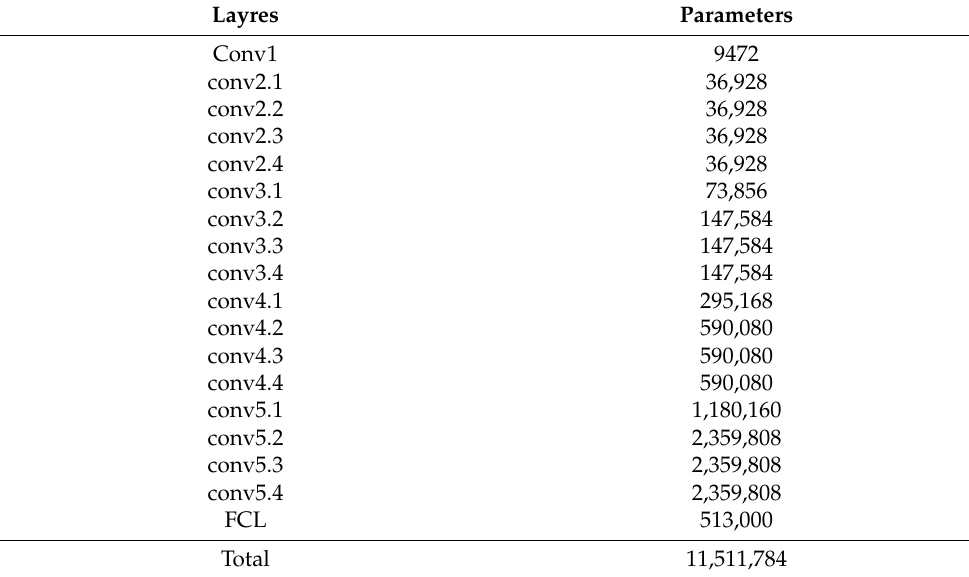
Table 2. The number of parameters per layer in the ResNet-18 model.